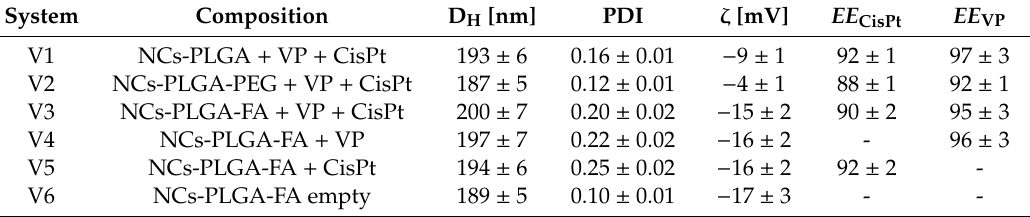
Table 1. Physicochemical characteristics of VP and Cis-Pt co-loaded NCs with various PLGA shells.